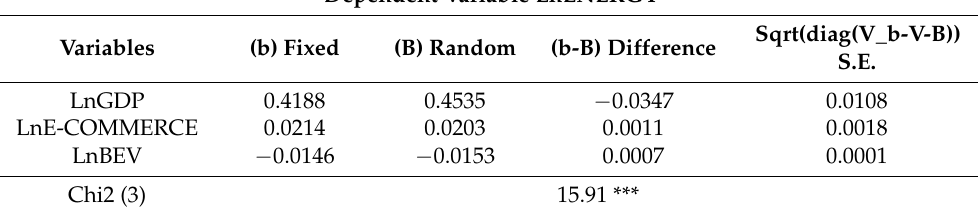
Table 9. Hausman test.